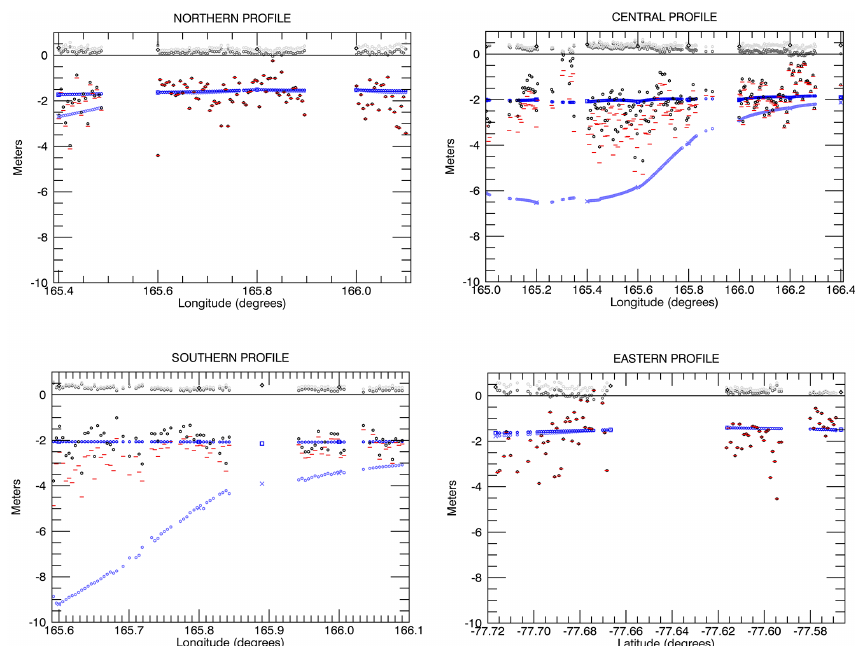
Figure 5. The four profiles with GNSS-derived surface elevation (light grey), interpolated drill-hole derived sea ice freeboard (dark grey), sea ice draft (dark blue) and sub-ice platelet layer draft (light blue). Red dashes indicate sea ice draft as predicted by Eq. (3) taking no account of the sub-ice platelet layer, black circles indicate the estimated draft with consideration of the sub-ice platelet layer as estimated by Eq. (4). Drill-hole measurements of surface elevation ( ♦ ), sea ice draft ( (cid:3) ) and sub-ice platelet layer draft ( × ) are also displayed for comparison with the